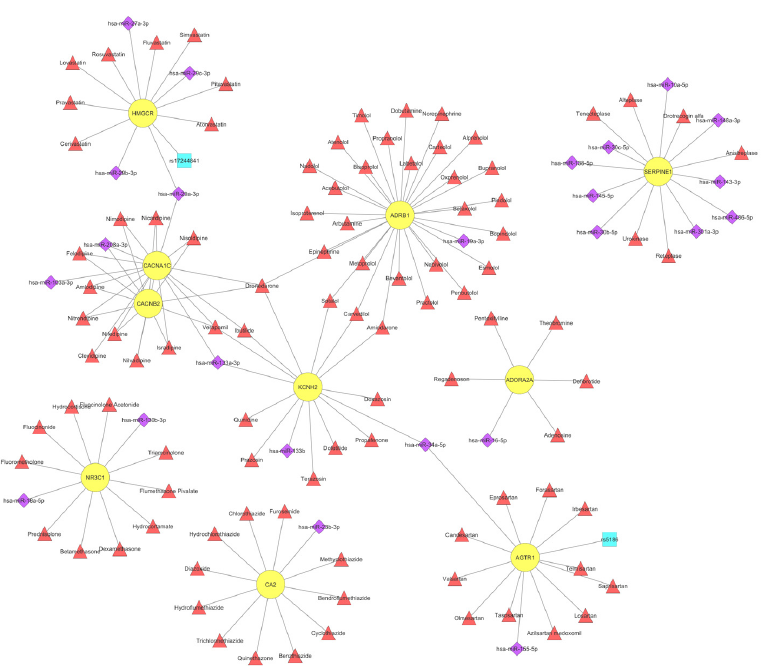
Figure 2. Network representation of ten gene-targets of CVD-associated miRNAs, which were also found to be targeted by most CVD-associated drugs from the CVDSP database [51]. The network displays 10 validated gene targets (circles in yellow), as well as 24 miRNAs (diamonds in purple), two SNPs (squares in turquoise) and 98 drugs (triangles in red) that are CVD-associated, and which target and/or affect them. The network was created using Cytoscape [59].